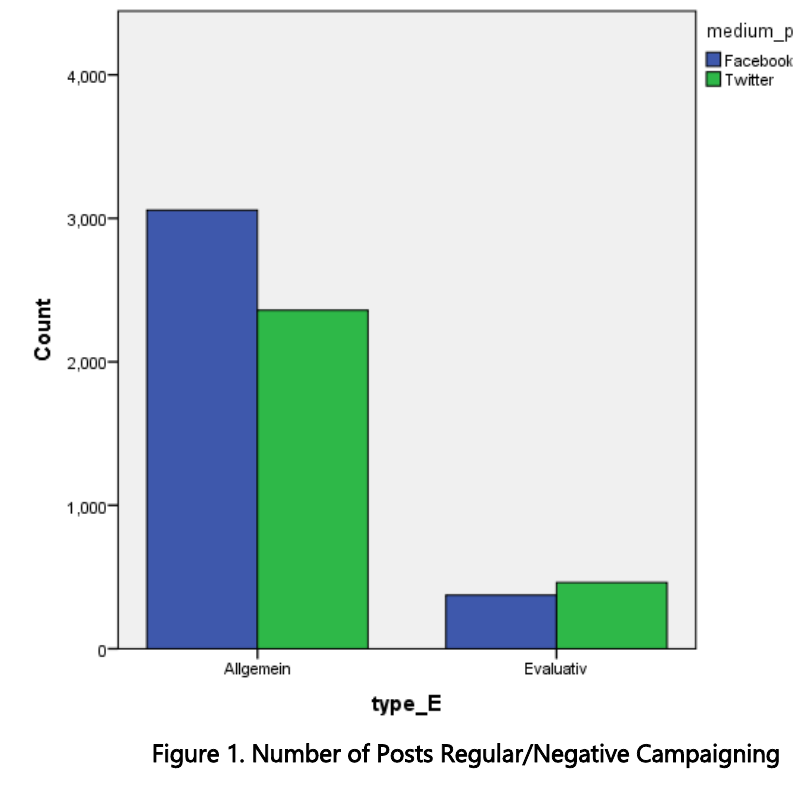
Figure 1. Number of Posts Regular/Negative Campaigning